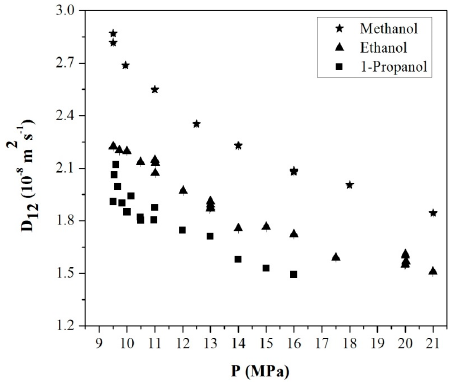
Figure 9. Binary diffusion coefficient of various organic solvents in scCO 2 at infinite dilution at 313.15 K as a function of pressure. Adopted with permission from [61]. Copyright (2017) American Chemical Society.